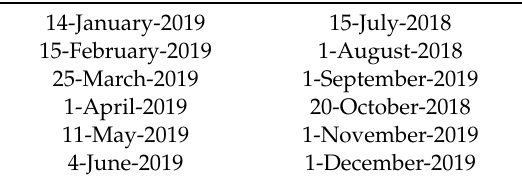
Table 2. Days Used for NN